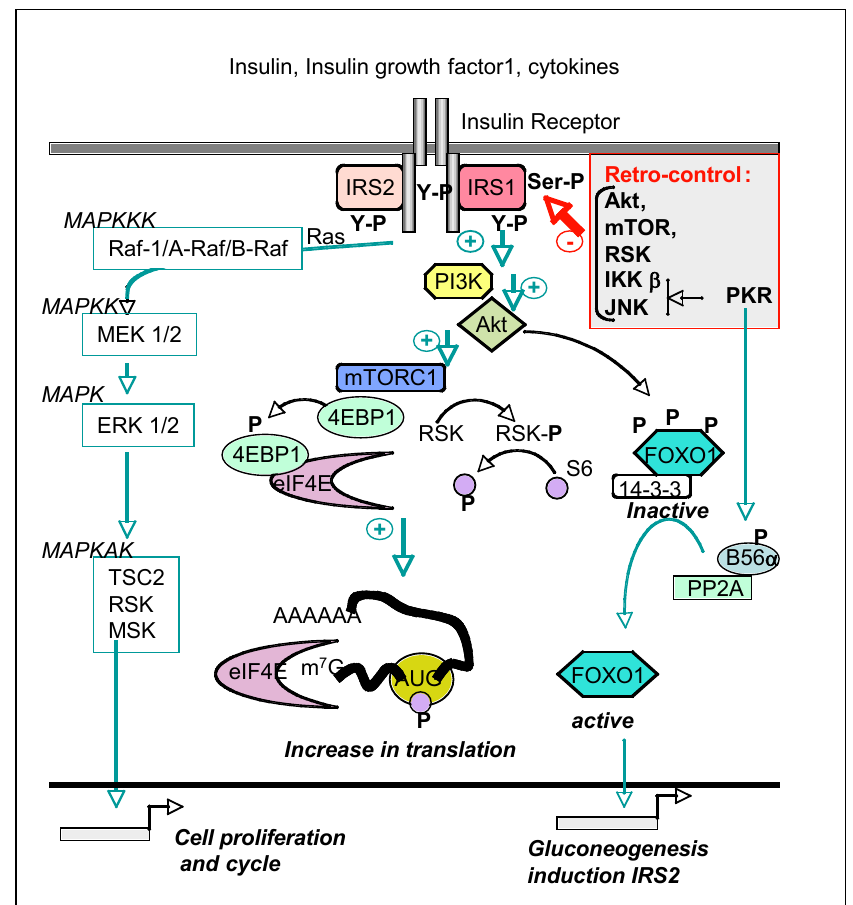
Figure 3. PKR and the Insulin signaling pathway. After binding of the insulin receptor to its different ligands, its intracytosolic chains autophosphorylate on tyrosine residues and phosphorylate the two substrates IRS1 and IRS2 on tyrosine residues to recruit the SH2-containing Phosphoinositol-3 kinase (PI3K). Lipid products generated by PI3K bind and activate Akt, which in turn activates mTORC1. The latter phosphorylates 4EBP1 and RSK (Ribosomal S6 kinase). As a result, 4EBP1 dissociates from the cap-binding eIF4E protein and RSK phosphorylates the S6 ribosomal protein. The outcome of this is an increase in translation. Activation of the insulin receptor triggers also the Mitogen Activated Protein Kinase (MAPK) cascade (reviewed in [85]) leading to the transcription of factors required for cell proliferation and cycle. Akt also negatively regulates the Forkhead BoxO transcription factor FOXO1 by phosphorylation. This maintains FOXO1 in the cytosol in a complex with the 14-3-3 protein and prevents gluconeogenesis or transcription of IRS2 when not needed. Retro-control of the insulin pathway occurs through phosphorylation of IRS1 on serine residues by Akt, mTOR, RSK and by PKR, the latter acting through the intermediate IKK β or JNK kinases. This prevents its interaction with the insulin receptor. However, PKR can also positively activate the insulin signaling by triggering FOXO1 dephosphorylation through the phosphorylation of B56 α , the regulatory subunit of the protein phosphatase